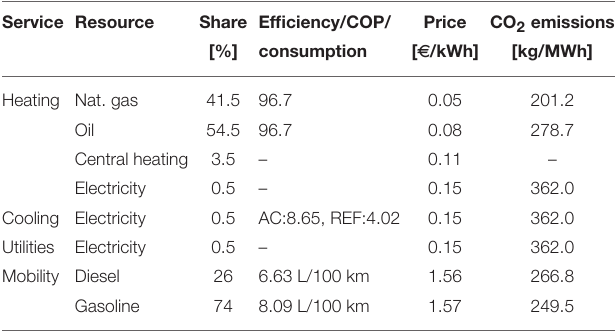
TABLE 5 | Parameters for energy consumption, economic, and environmental analysis. Service Resource